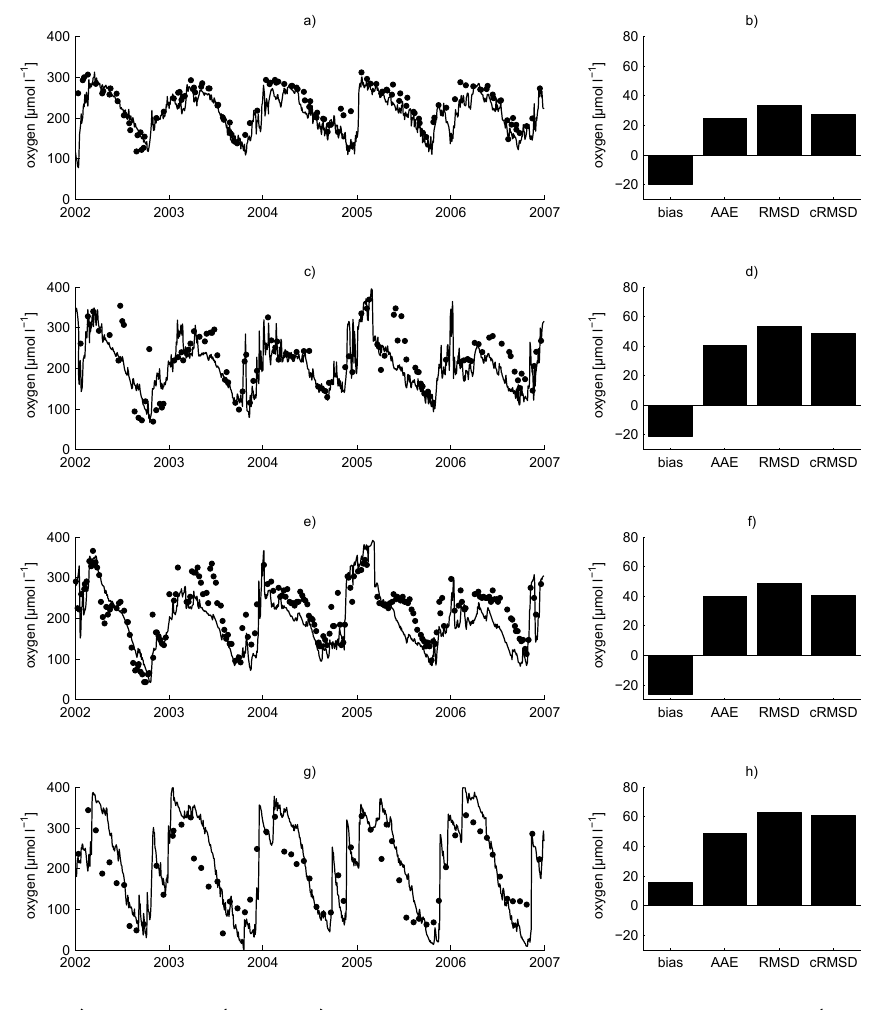
Fig. 4. Simulated (black line) and observed (black dots) DO concentrations together with statistical measures (right panels) for the bottom layer of the model at station (a, b) 413, (c, d) 925, (e, f) “gb” and (g, h) Arkona Basin.